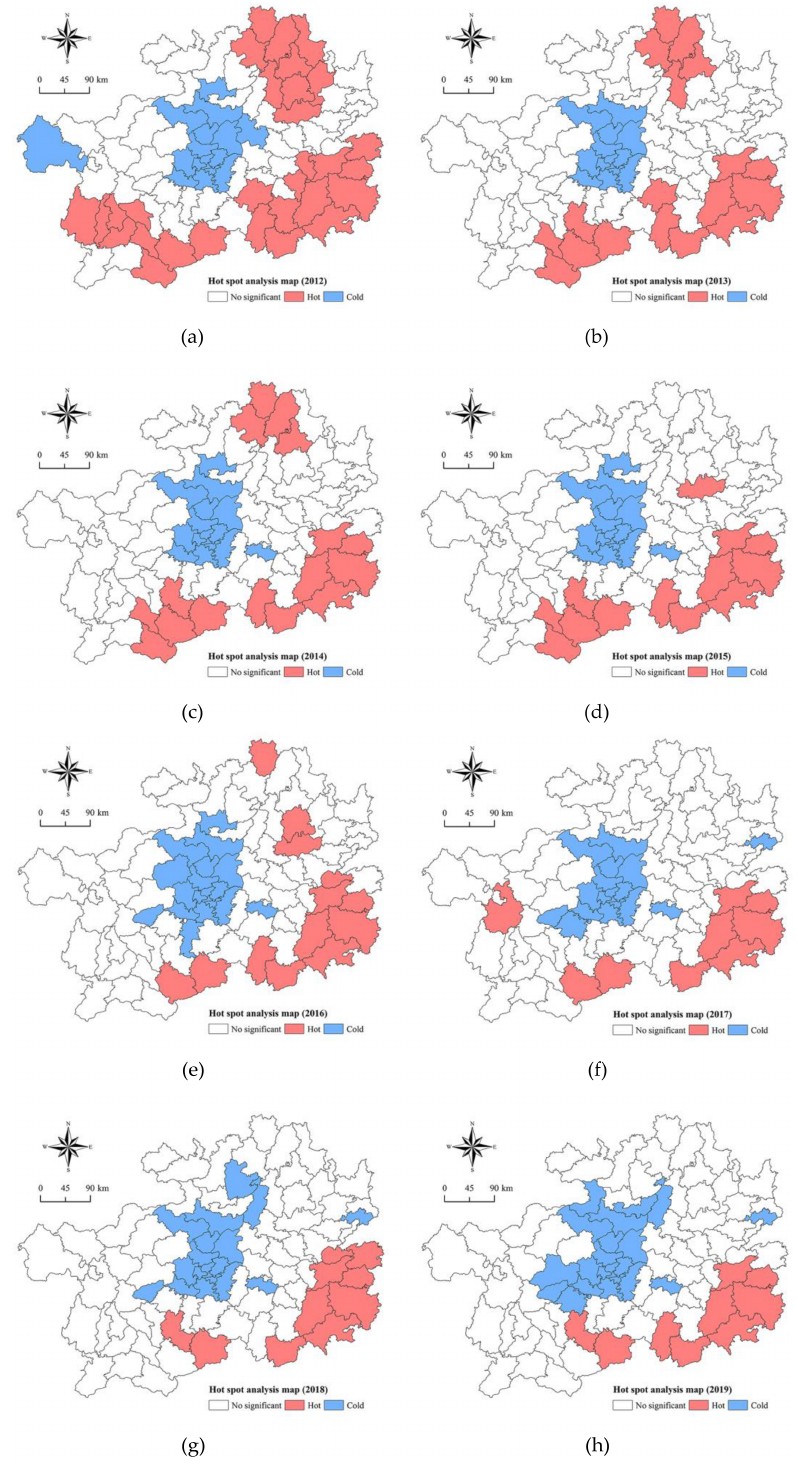
Figure 11. Hot-cold spot map of poverty probability at the county level; ( a ) hot-cold spot analysis map of poverty probability at the county level in 2012, ( b ) hot-cold spot analysis map of poverty probability at the county level in 2013, ( c ) hot-cold spot analysis map of poverty probability at the county level in 2014, ( d ) hot-cold spot analysis map of poverty probability at the county level in 2015, ( e ) hot-cold spot analysis map of poverty probability at the county level in 2016, ( f ) hot-cold spot analysis map of poverty probability at the county level in 2017, ( g ) hot-cold spot analysis map of poverty probability at the county level in 2018, ( h ) hot-cold spot analysis map of poverty probability at the county level in